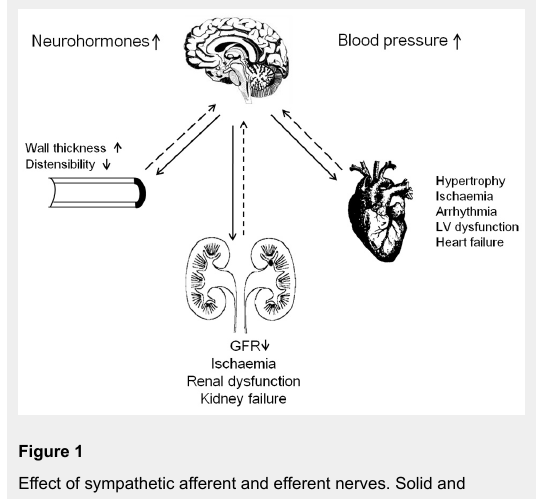
Table 1: Effects of renal denervation on blood pressure and renal function in the Symplicity Registry. Timeline in months Blood pressure Number of patients with measurements Mean systolic blood pressure changes (mm Hg) Renal function Number of patients with measurements